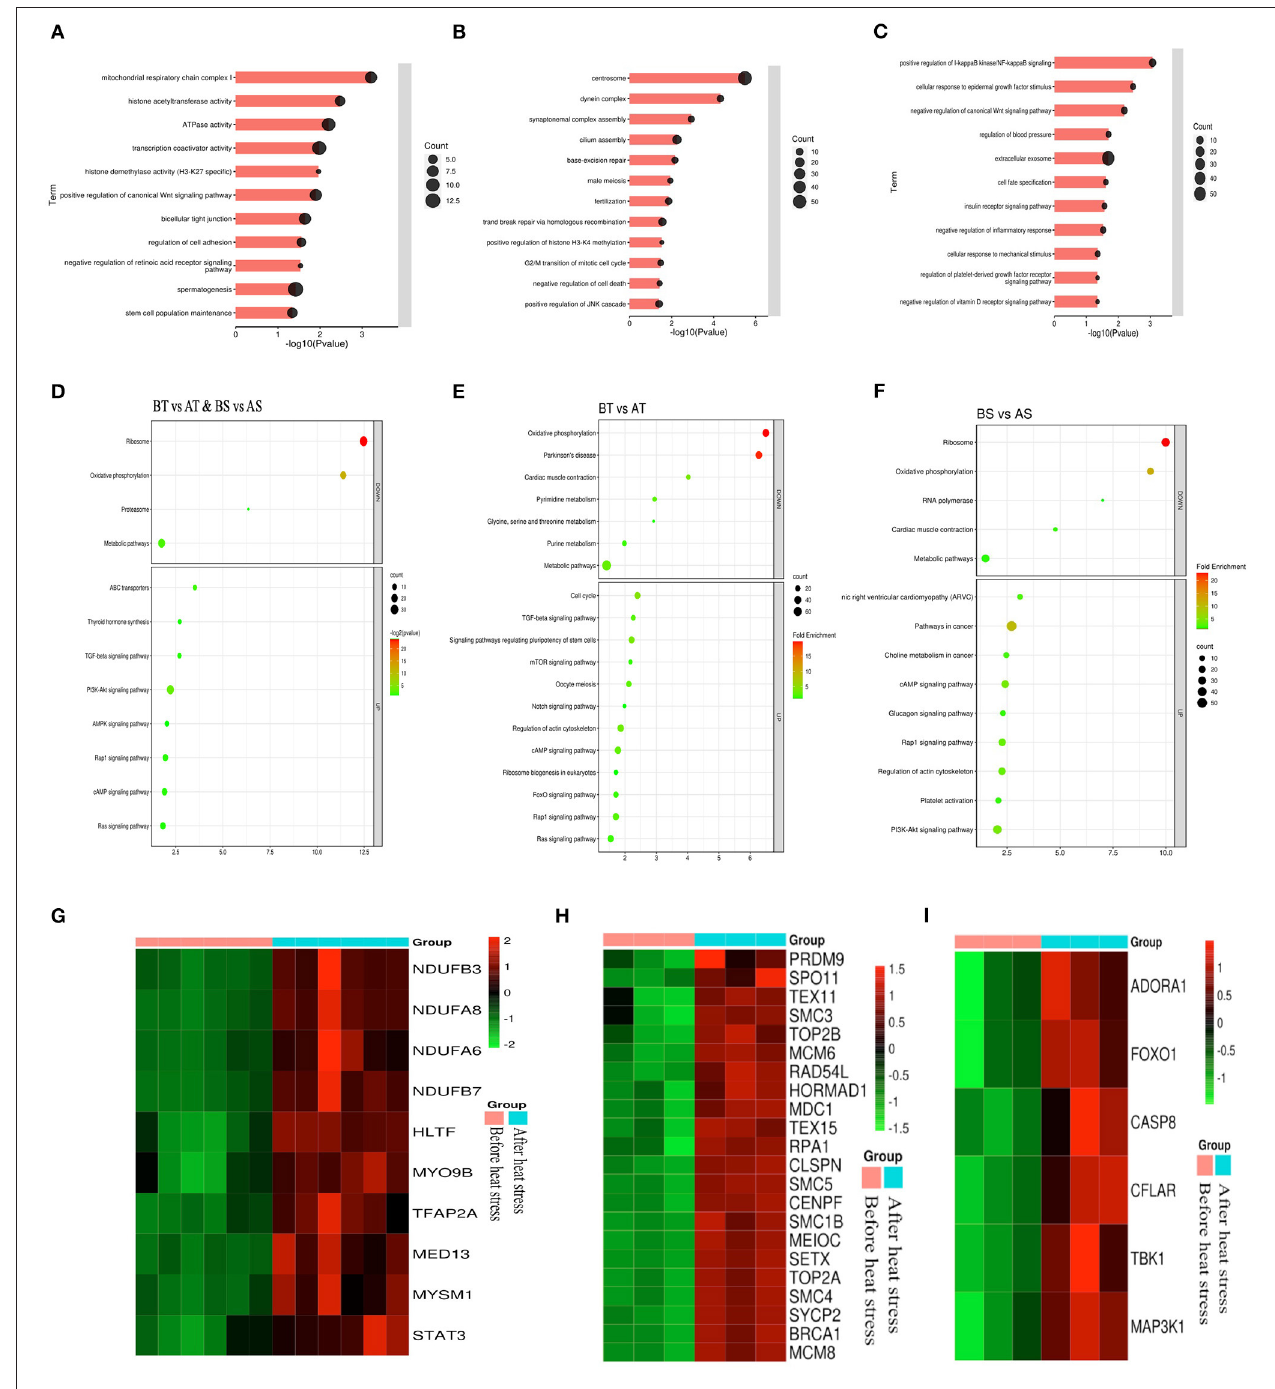
FIGURE 7 | Analysis of common differential genes in the testis transcriptomes of Turpan black sheep and Suffolk sheep before and after HS treatment. (A–C) Common differential genes, GO enrichment analysis of Turpan black sheep and Suffolk sheep. (D–F) KEGG pathway enriched for differential genes. (G–I) Representative differential gene